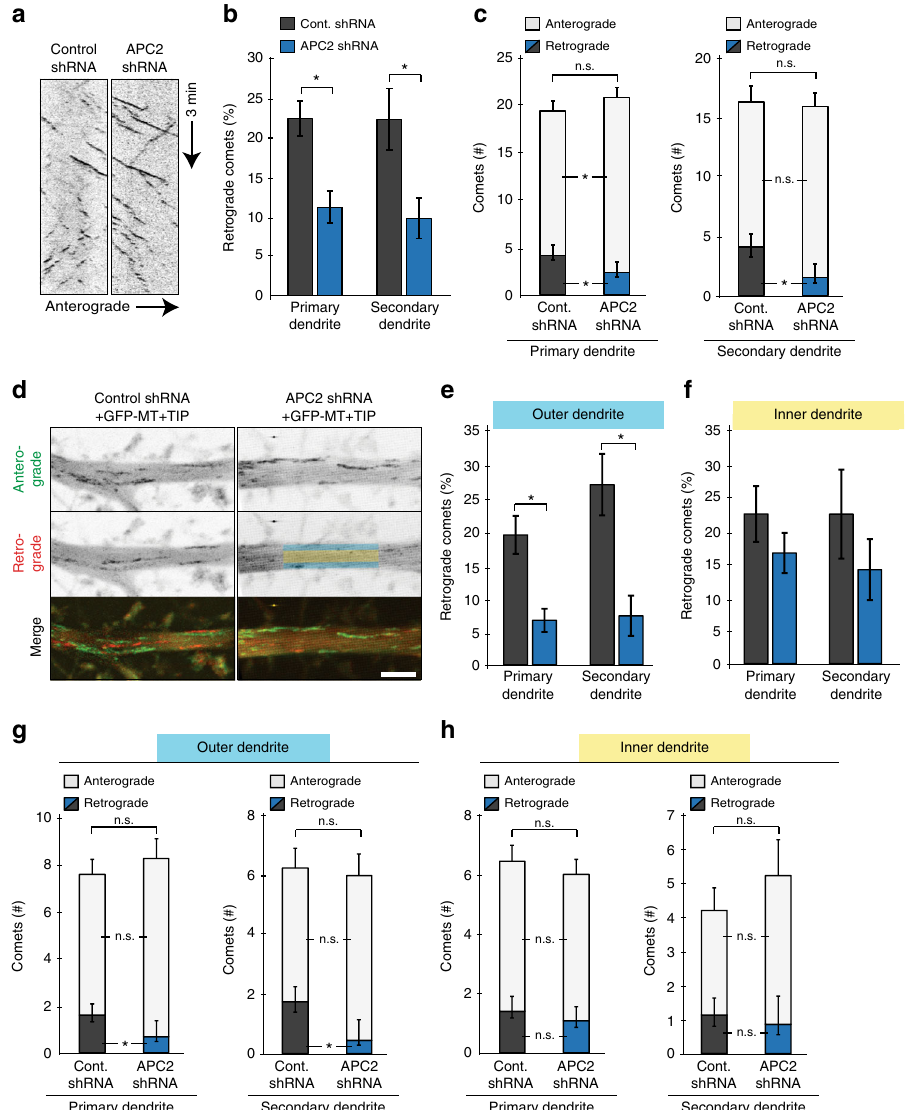
Fig. 3 APC2 depletion alters minus-end-out microtubule dynamics in dendrites. a Representative kymographs of GFP-MT + TIP in neurons co-transfected with either control or APC2 shRNA and imaged at DIV15 – 16. b Percentage retrograde GFP-MT + TIP comets in dendrites in 6.7 µ m long regions at least 30 µ m away from the cell body in primary dendrite condition and at least 30 µ m away from the fi rst branch point in secondary dendrite condition. Calculated from 3 min movies with frames acquired every 0.5 s ( n = 41 primary dendrites control shRNA, n = 42 primary dendrites APC2 shRNA, p ≤ 0.001, n